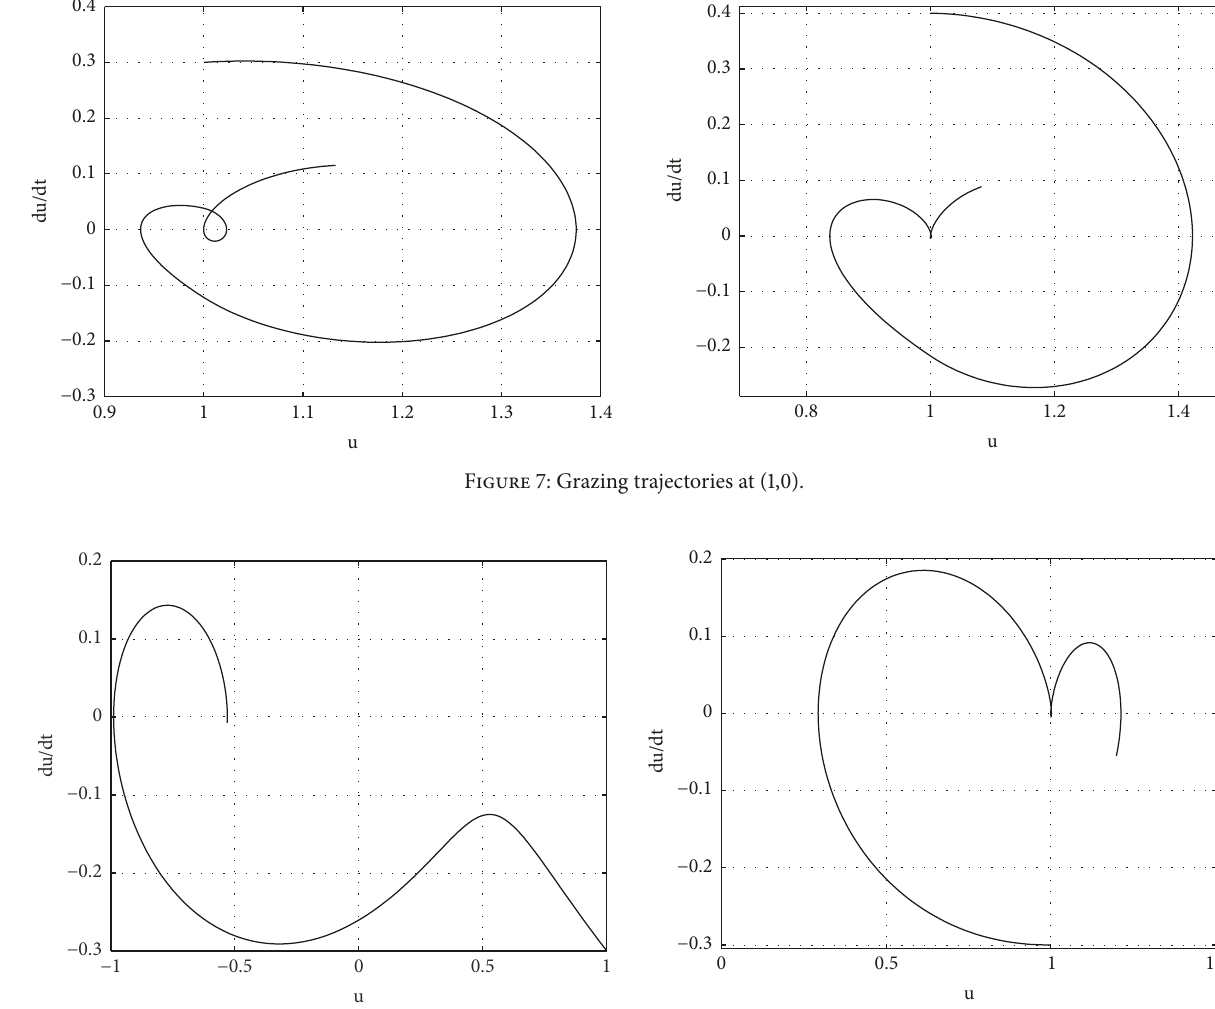
Figure 8: Grazing trajectories at (-1,0) and (1,0).